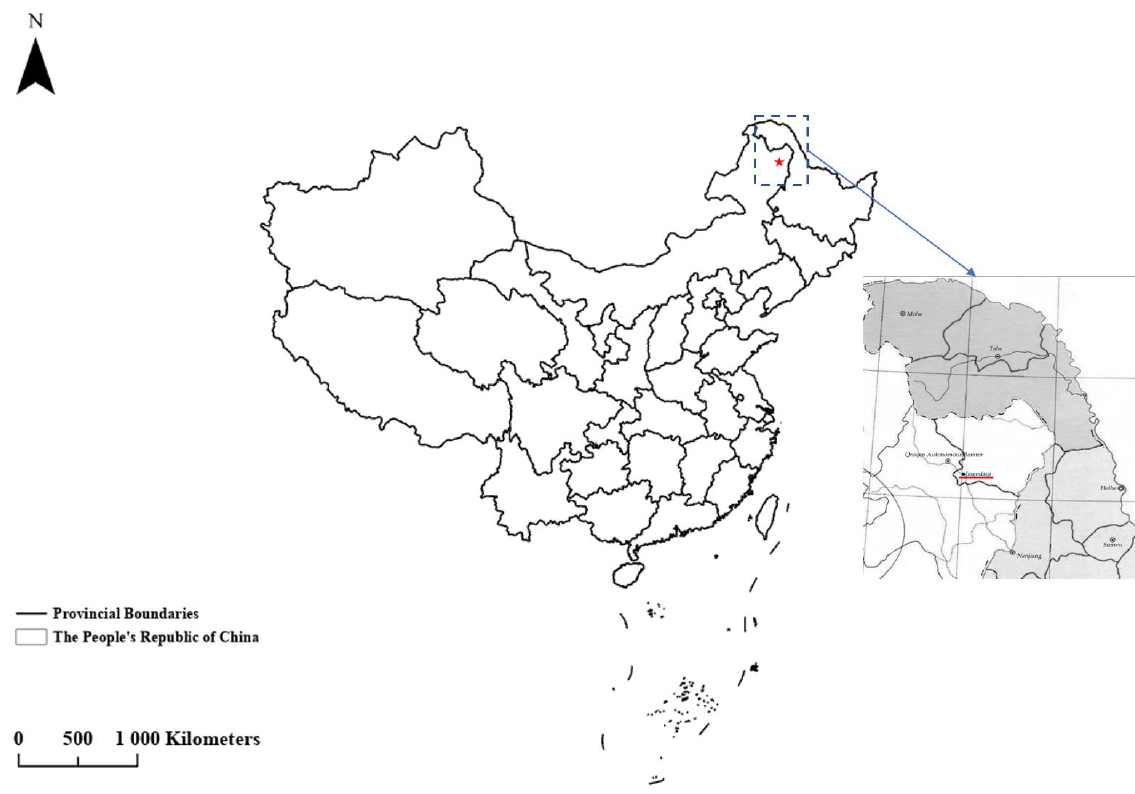
Figure 1. Geographical location of Cuifeng Forest Farm.